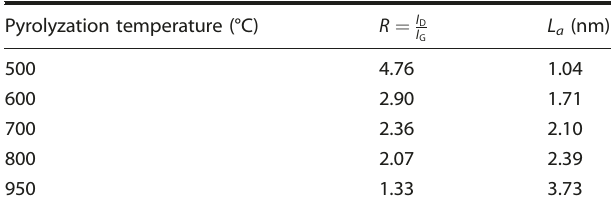
Fig. 2 Raman spectra of nano fi ber bundles pyrolyzed at a 500 °C, b 600 °C, c 700 °C, d 800 °C, and e 950 °C. Table 1. Tabulating the “ R ” over the range of different pyrolyzation temperatures